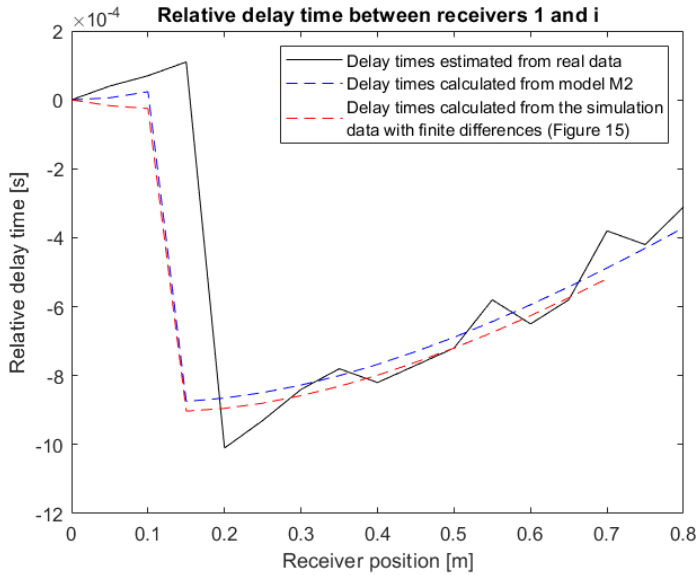
Figure 20. Comparison of the relative delay times between the real data and Model M2.